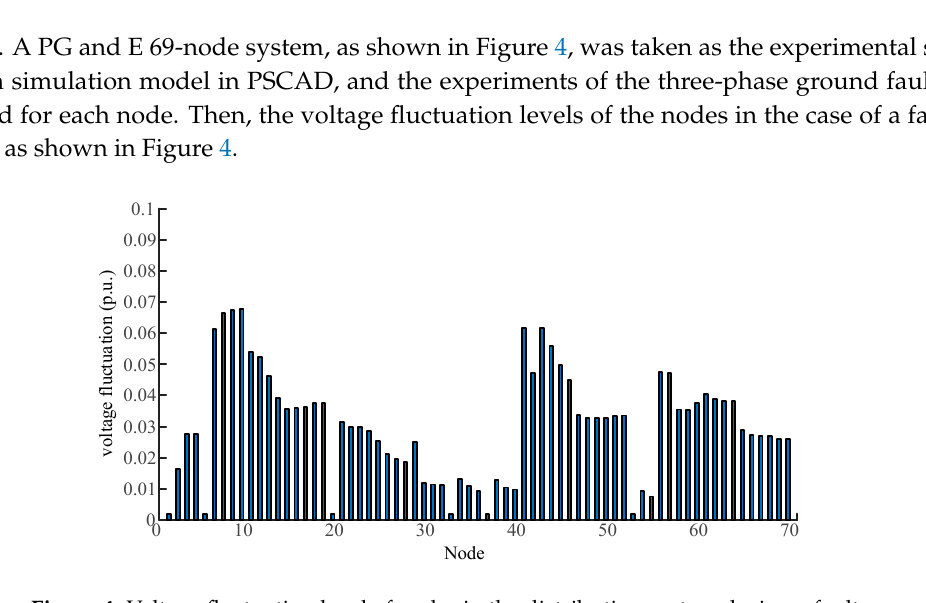
Figure 4. Voltage fluctuation level of nodes in the distribution system during a fault.